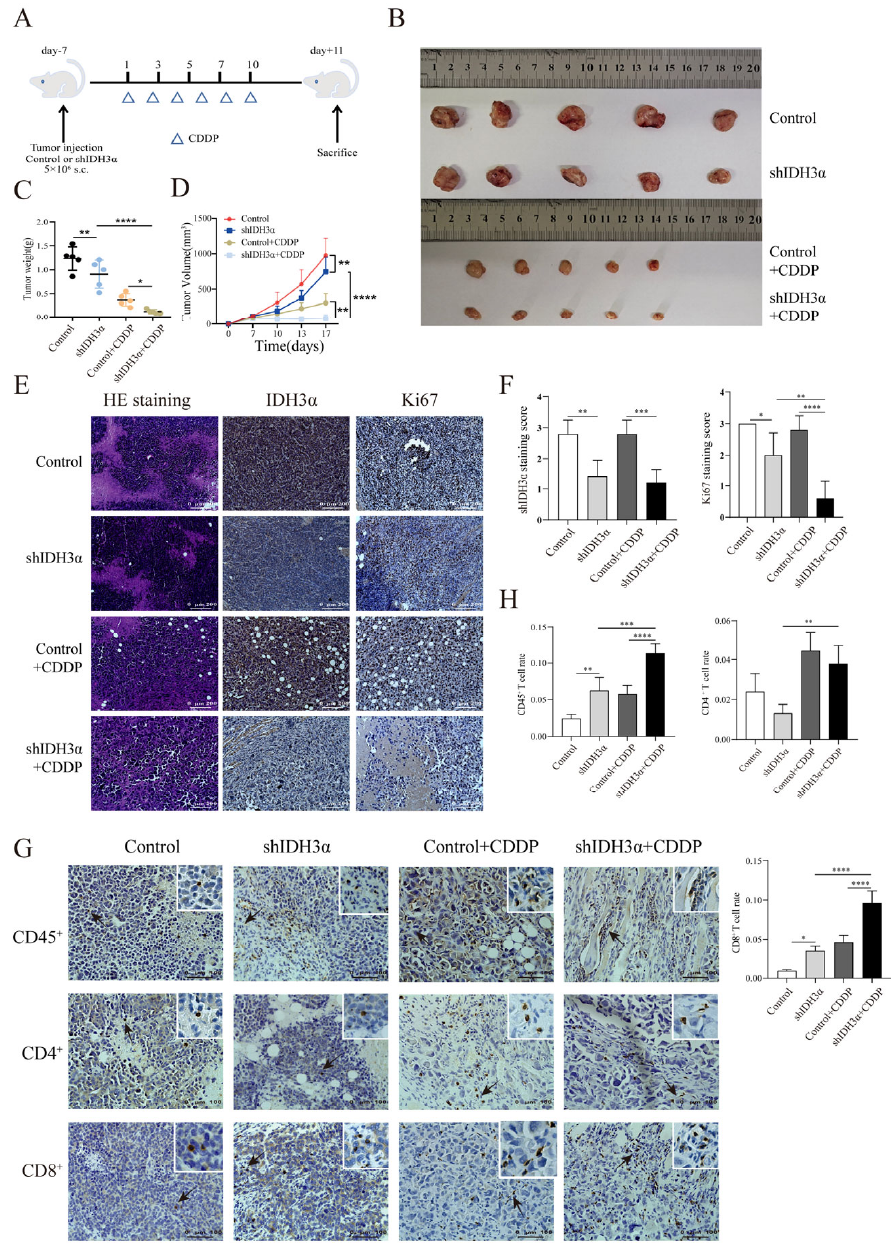
Figure 6. Effects of IDH3 α on tumor growth in vivo and CD8 + T cell infiltration proportion in tumor tissues after cisplatin treatment. ( A ) In vivo experimental design. U14 mouse cervical cancer cells were transduced with lentivirus and injected into the inguinal region of C57BL/6 wild ‐ type mice (5